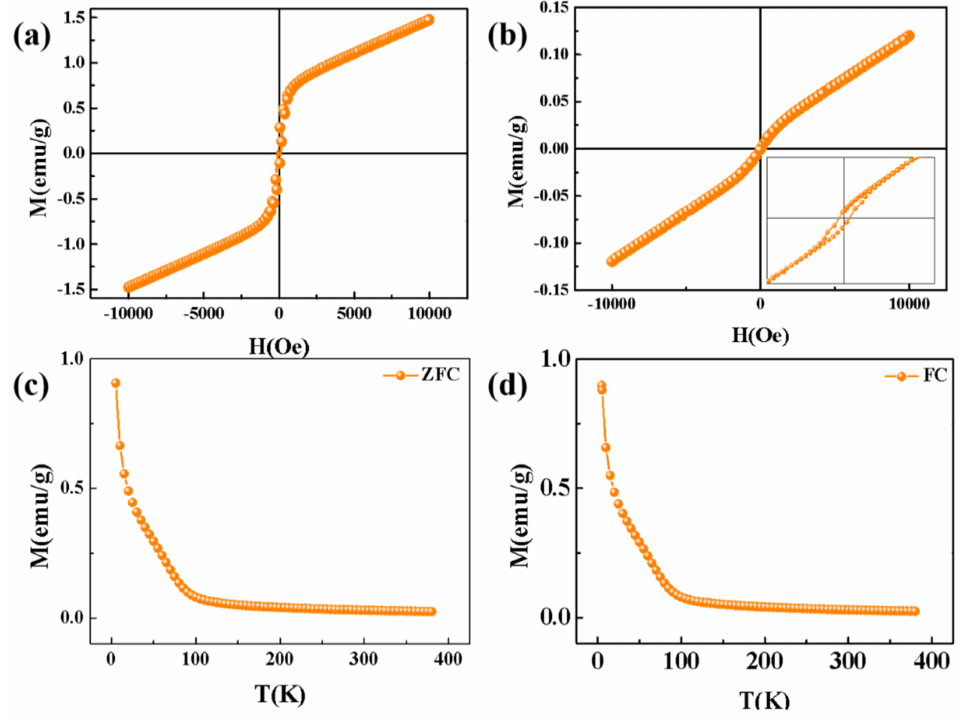
Figure 8. ( a ) M-H curve of Co 3 Sn 2 S 2 annealed at 450 ◦ C for 2 h; ( b ) M-H curve of Co 3 Sn 2 S 2 before annealing; ( c ) ZFC curve of Co 3 Sn 2 S 2 before annealing; ( d ) FC curve of Co 3 Sn 2 S 2 before